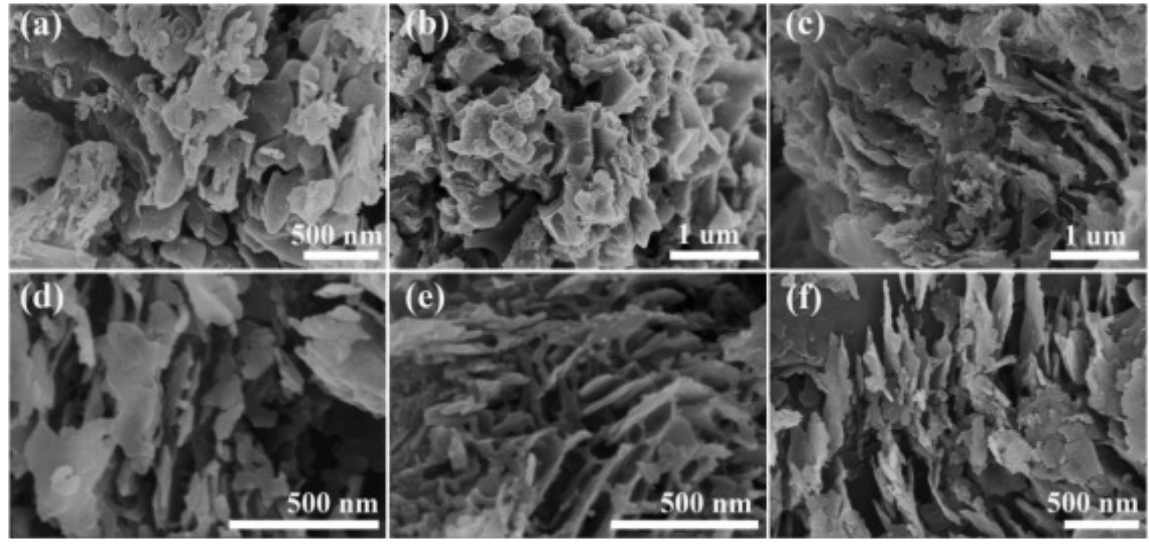
Figure 6. SEM images of ( a ) SC 3 N 2 , ( b ) MoS 2 and ultrathin array-like nanosheet, ( c ) MoS 2 /SC 3 N 4 - 0.5%, ( d ) MoS 2 /SC 3 N 4 -1.5%, ( e ), MoS 2 /SC 3 N 4 -2.5%, and ( f ) MoS 2 /SC 3 N 4 -5.0%. Reprinted with permission from Ref. [88]. Copyright 2021 Elsevier .